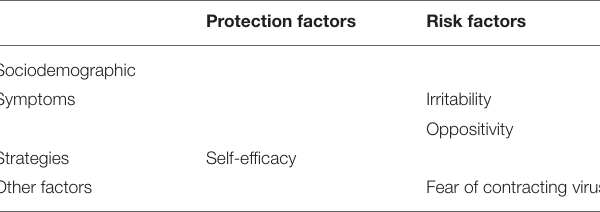
TABLE 10 | Risk and Protective Factors for the Course of